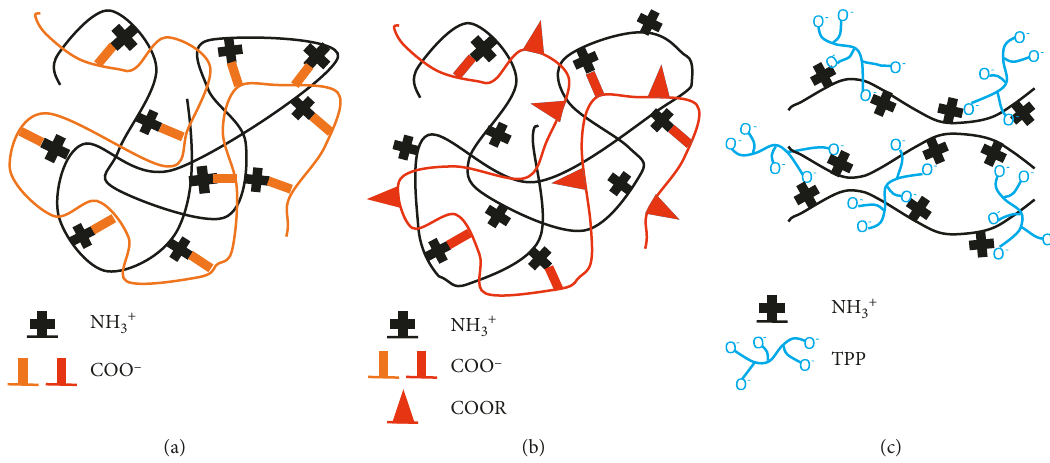
Figure 6: Schematic interaction of (a) chitosan-alginate (CA)